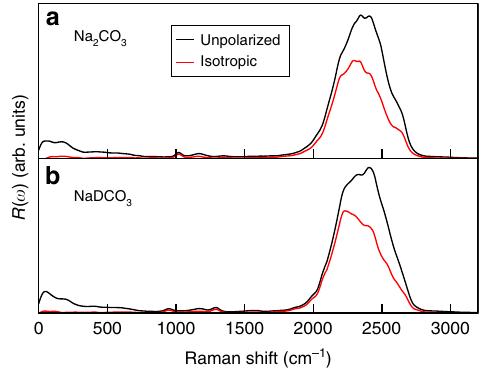
Fig. 4 Raman spectra of 0.9 molality solutions at ~9 GPa and 600 K. Calculated unpolarized (black line) and isotropic (red line) spectra of the sodium carbonate and deuterated sodium bicarbonate solutions are shown in the upper and lower